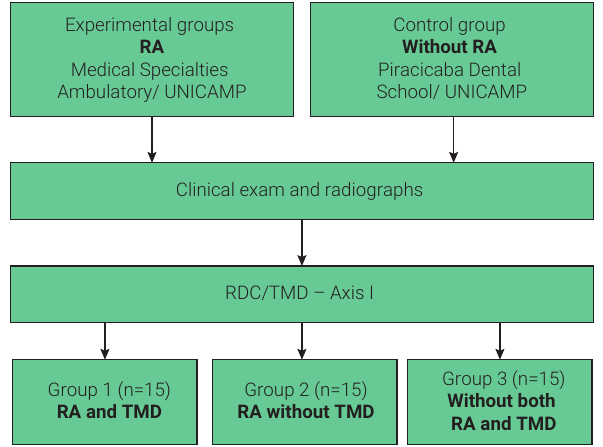
Figure 1. Flowchart for selection of